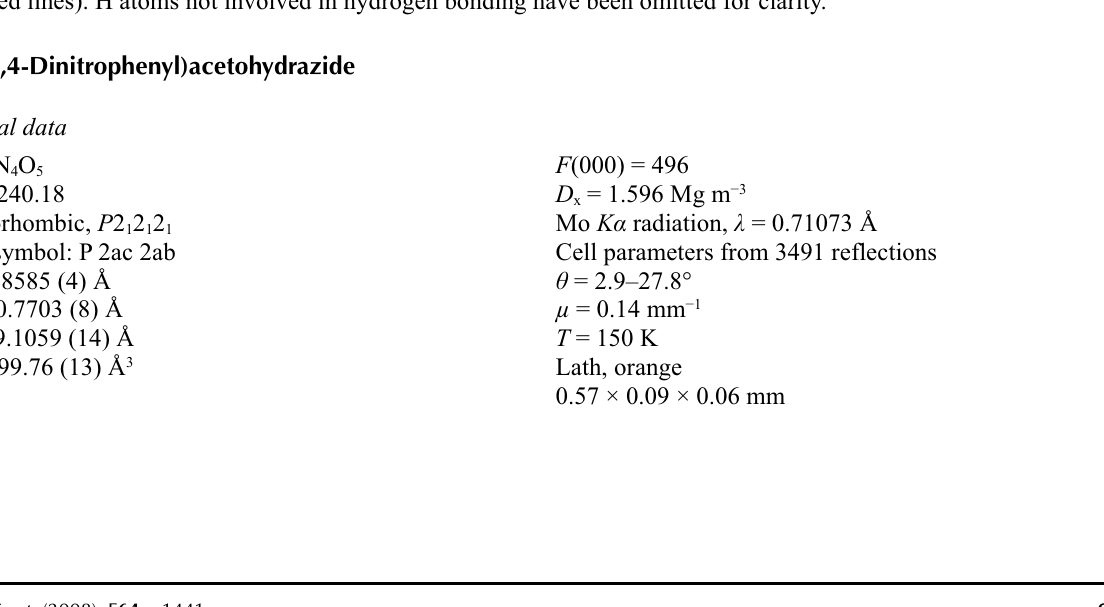
Perspective view of the three-dimensional crystal packing showing hydrogen-bonds and other intermolecular interactions (dashed lines). H atoms not involved in hydrogen bonding have been omitted for